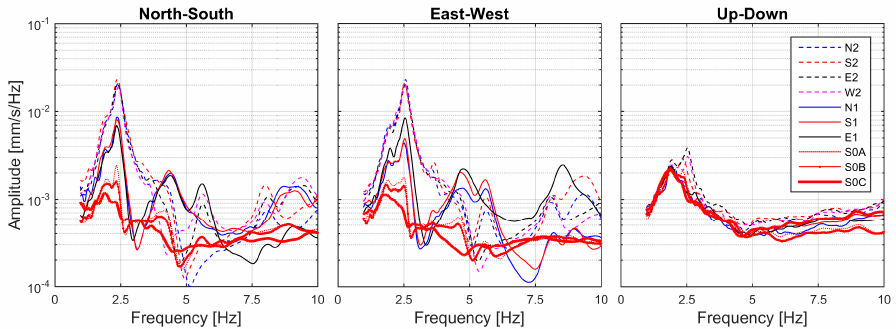
Figure 3. Fourier amplitude spectra of velocity, Jagannath